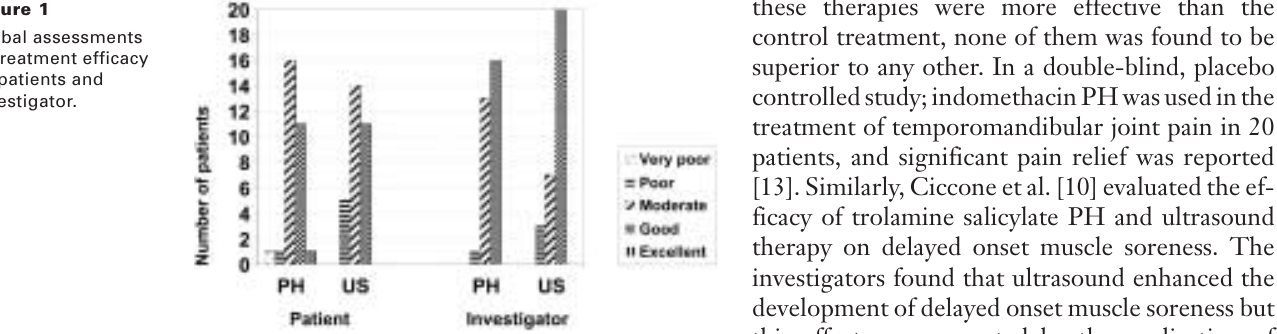
Global assessments of treatment efficacy by patients and